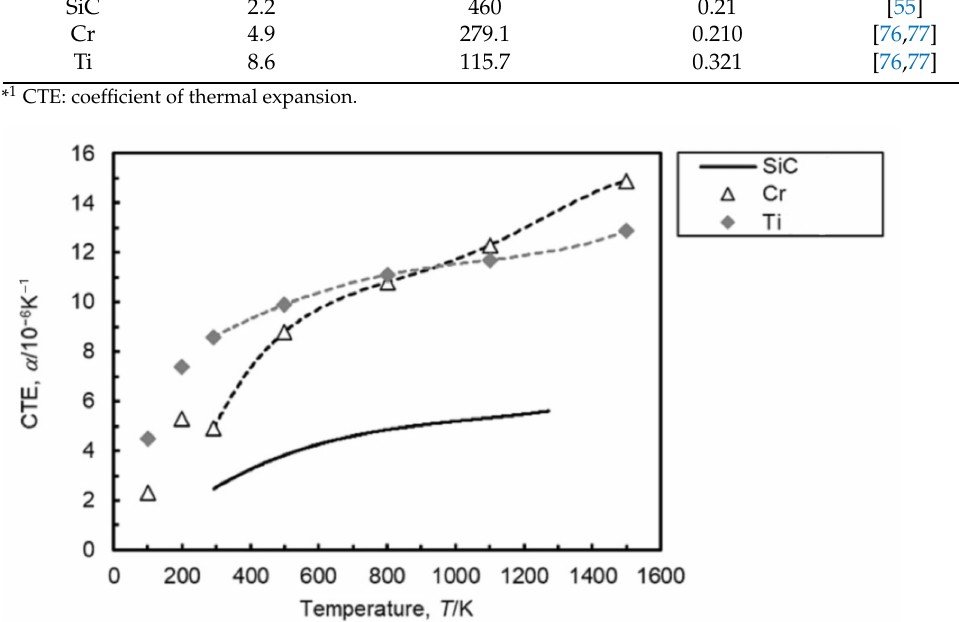
Figure 15. Coefficient of thermal expansion (CTE) of SiC, Cr, and Ti. The dashed lines are regression curves used for calculation of thermal stress. SiC [69], Cr [76], Ti